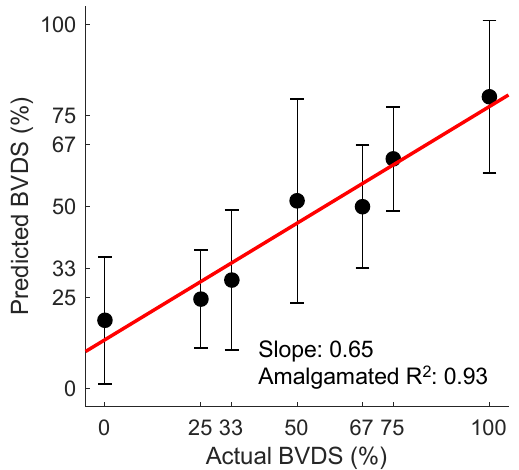
Figure 13. The BVDS metric performance in predicting decompensation. The line of best fit through the mean of the aggregated predictions for all animals during all portions of the experiment is shown in red. BVDS levels range on a scale from 0 to 100, with 100 indicating full decompensation status. The slope of the line (0.65) is an indicator of the overall prediction accuracy, while the R2 value of 0.93 is an indicator of the prediction consistency between BVDS levels. Standard deviation bars are also shown for each level, indicating the consistency of predictions within a single decompensation level. Image modified from [12].